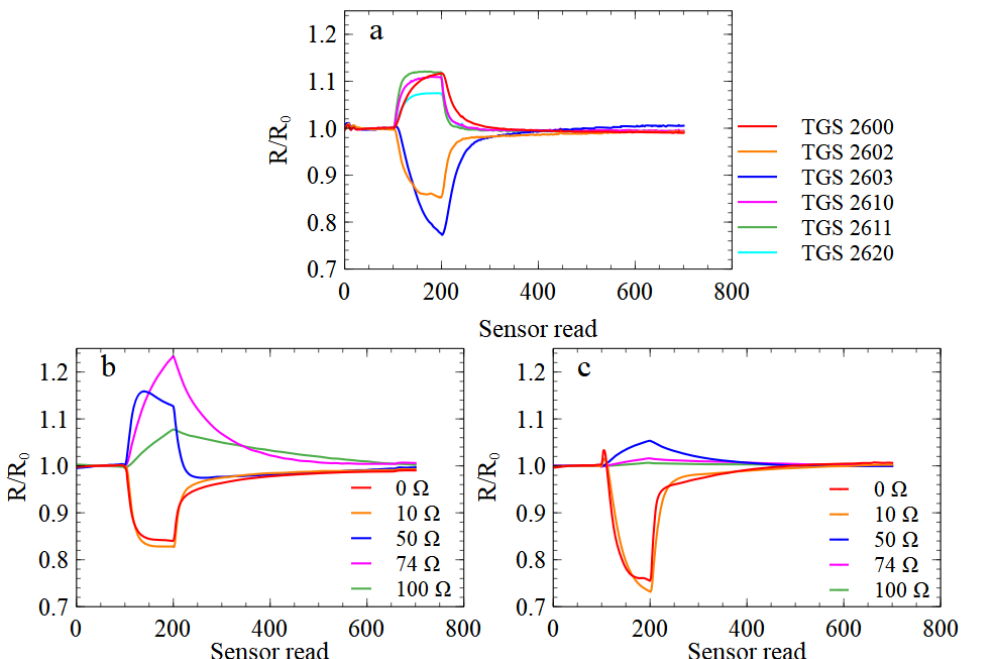
Figure 2. Examples of sensors’ responses to a sample of Rhizoctonia odour. Responses of sensors are displayed in the subfigures as marked: ( a ) in PW4 e-nose device, ( b ) in PW6 with TGS2602 sensors and ( c ) with TGS2603 sensors. The y-axis represents the sensor resistance R relative to the resistance in clean air R 0 . The x-axis represents the sensor resistance read number counted from the start of the measurement of the sample. The sensors were read for 1.22 seconds